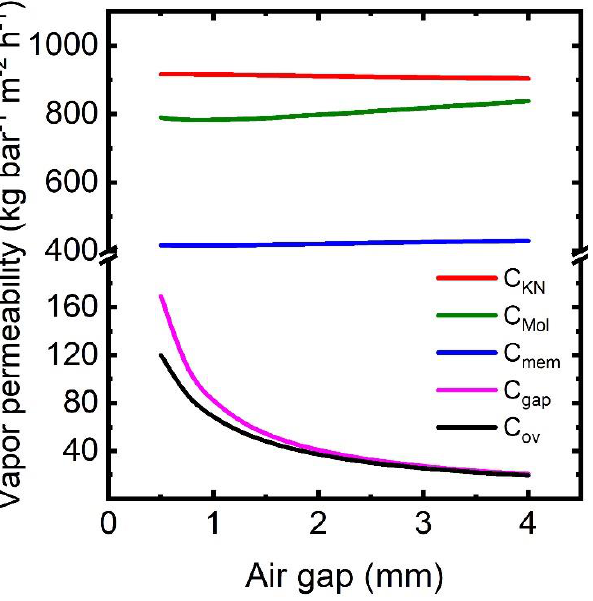
Figure 10. Vapor permeabilities in different mass transport regions of the AGMD process. C KN , C Mol , C mem , C gap , and C ov denote the vapor permeability corresponding to Knudsen diffusion, molecular diffusion, diffusion inside the porous membrane, mass transfer through the air gap, and overall mass transfer through the membrane and air gap.